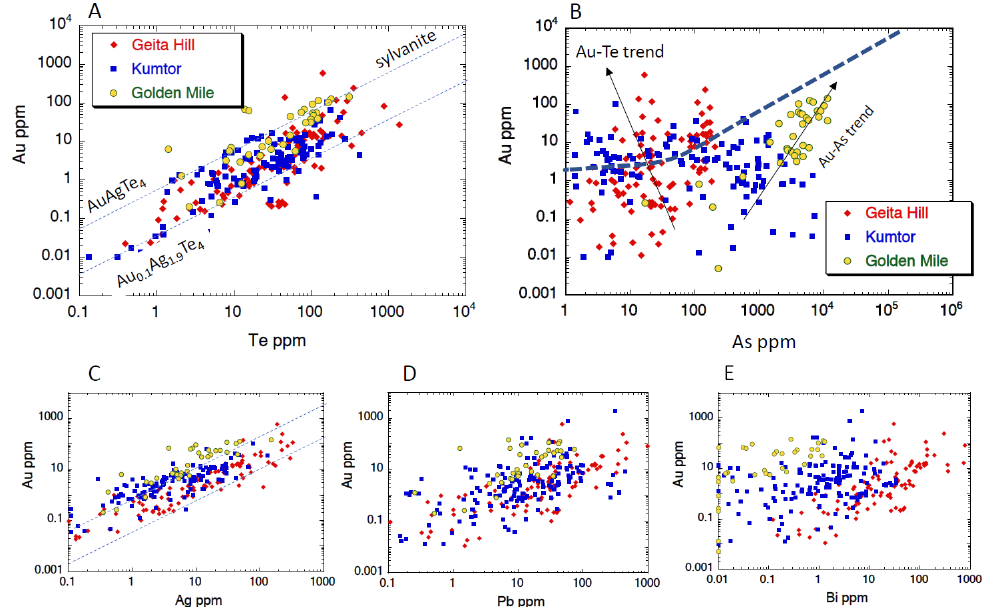
Figure 11. LA-ICPMS data on pyrite for Geita Hill, Kumtor and Golden Mile. The Au-Te and Au-Ag associations suggest Au-Ag tellurides nano- to micro-inclusions in pyrite are a significant host for Au. Golden Mile (Fimiston) pyrite exhibits both an Au-Te and Au-As association. ( A ): Te-Au plot; ( B ): As-Au plot; ( C ): Ag-Au plot; ( D ): Pb-Au plot; ( E ): Bi-Au plot. Table 2. Mean values of As, Te, Au and Ag in pyrite from the deposits discussed in this study. Mean values of Au, As and Te in pyrite from the eleven deposits (plus Sukhoi Log; [26]) are